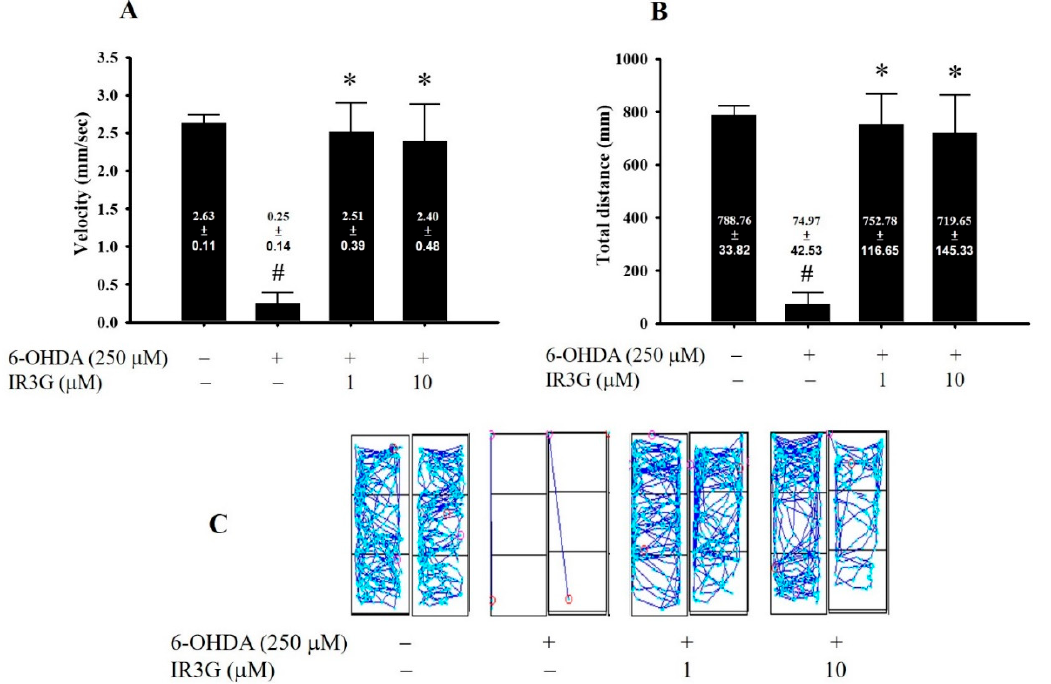
Figure 5. Effects of IR3G on the 6 ‐ OHDA ‐ induced locomotor deficit in zebrafish PD model. larvae were pretreated with 1 or 10 µ M IR3G from 9 h post-fertilization (hpf) to 5 days Zebrafish larvae were pretreated with 1 or 10 μ M IR3G from 9 h post ‐ fertilization (hpf) to 5 days post ‐ fertilization (dpf) and then challenged with 250 μ M 6 ‐ OHDA from 2 to 5 dpf. ( A ) Mean velocity (mm/s); ( B ) Total swimming distance (mm); and ( C ) Typical swimming pattern in the control, 6 ‐ OHDA ‐ challenged, 6 ‐ OHDA plus IR3G ‐ treated groups are shown ( n = 16). Data showed that IR3G